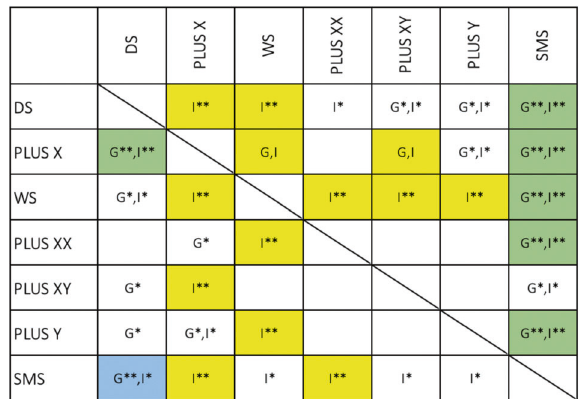
Fig. 1 Synopsis of results from pairwise mixed model ANOVAs (above diagonal) and ANCOVAs with cognitive impairment covaried (below diagonal). To test for differential ART subscale pro fi les between each unique pair of GDD groups, we ran 21 (number of unique GDD group pairings) 2 (GDD group) × 5 (SRS- 2 subscale) mixed-model ANOVAs. For these analyses, group effects (e.g., GDD 1 is more or less impaired overall than GDD 2 on the SRS- 2 subscales) and group*subscale interaction effects (e.g., there is a difference in the SRS-2 pro fi le for GDD 1 vs. GDD 2) were evaluated and results are presented above the diagonal. Parallel analyses were also completed using ANCOVA including cognitive impairment as a covariate and results are presented below the diagonal. When interpreting the fi gure, note the following. Main effects of group were denoted with a ‘ G ’ ; group*scale interactions were denoted with an ‘ I ’ . Instances in which there was a main effect of group or group*scale interaction that did not survive Bonferroni correction are denoted with a single asterisk (* p < 0.05); those that survived Bonferroni correction are denoted with a double asterisk (** p < 0.05 — Bonferroni corrected). Finally, to aid interpretation, color coding was implemented as follows. When a main effect of group was identi fi ed that survived Bonferroni correction, the cell in the matrix was color coded blue . When there was a Bonferroni-corrected group*subscale interaction, the cell was color coded yellow . Instances in which there was both a main effect of group (magnitude of impairment) and a group* subscale interaction (SRS-2 pro fi le difference) following Bonferroni correction were color coded green impairment, scatterplots (with robust correlation coef fi cients) of the relationship between each SRS-2 subscale and cognitive impairment are provided for each GDD group (Fig. 4), given the rarity of these conditions.